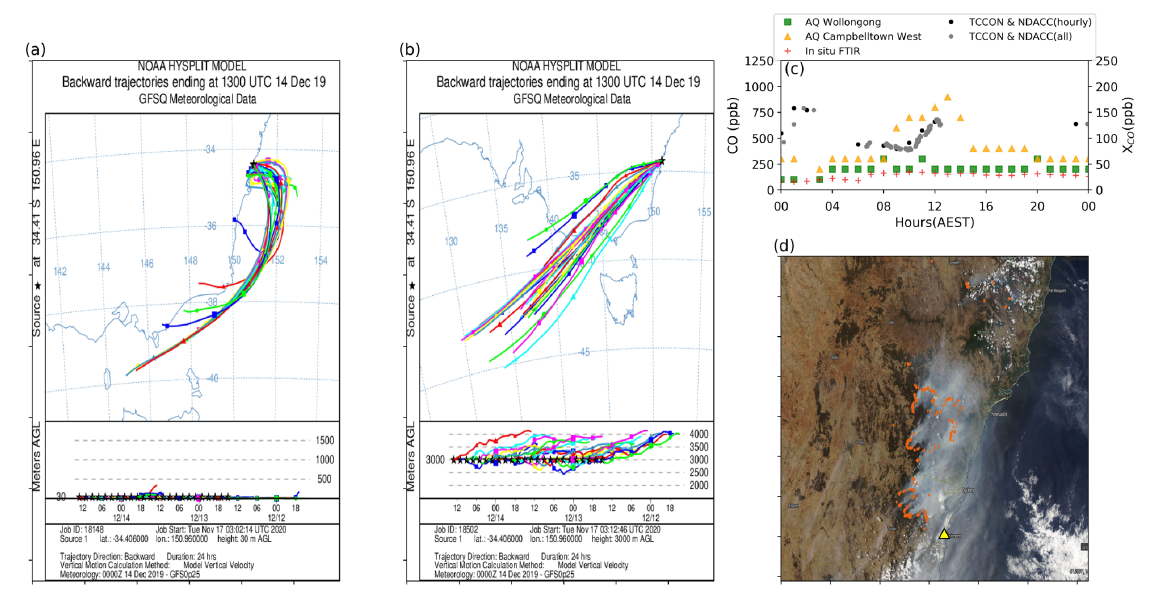
Figure 9. 14 December 2019: 24 h NOAA HYSPLIT back trajectories (UTC) at ( a ) 30 m and ( b ) 3000 m; ( c ) Hourly averaged surface in situ CO measurements at Wollongong air quality monitoring site (green squares), Campbelltown West air quality monitoring site (yellow triangles) and Wollongong in situ FTIR (red crosses). Black and grey dots show hourly averaged column CO measurements (TCCON & NDACC) and all native temporal resolution column measurements, respectively (in AEST: UTC + 10 h). ( d ) MODIS hotspot image with thermal anomalies [68] (zoomed in for southeast Australia). The UOW measurement site is marked with a yellow